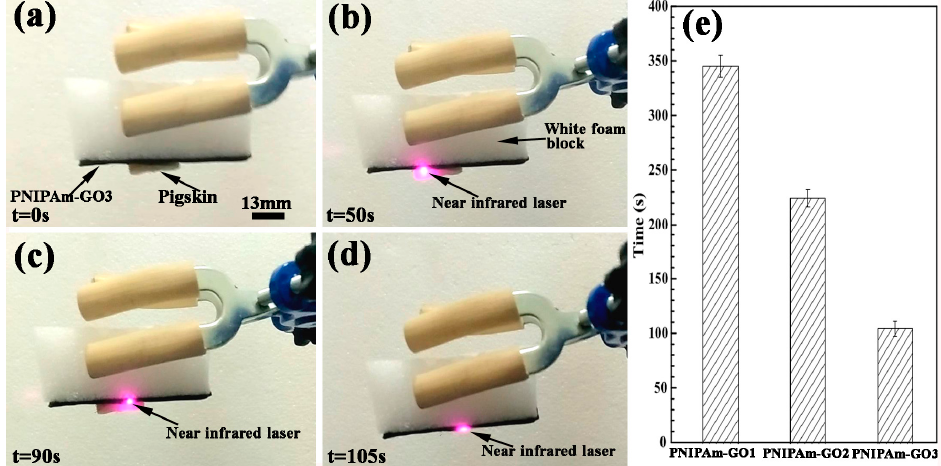
Figure 8. ( a – d ) detachment process of PNIPAm-GO3 hydrogel and ( e ) the detachment rate of PNIPAm hydrogels with 1, 2, and 3 mg/mL GO.